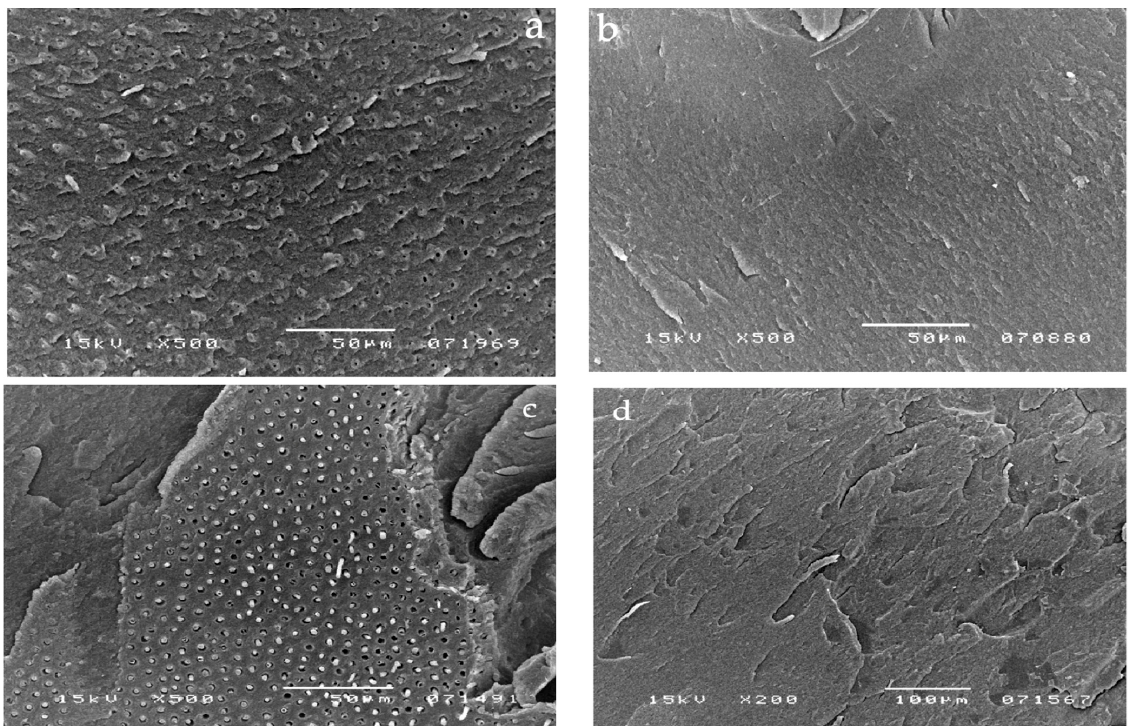
Figure 3. SEM photomicrographs illustrating the fractured surfaces for samples bonded with Clearfil Protect Bond. SEM analysis showed the absence of droplets within the adhesive layer of this DBA applied without pulpal pressure (0 cm H 2 O) ( a ) and simultaneously to pulpal pressure (20 cm H 2 O) ( b ). ( c , d ) micrograph show a representative sample of Clearfil Protect Bond applied and cured before the application of pulpal pressure (20 cm H 2 O). A high density of resin tags (cohesive fracture) and no droplets were displayed.